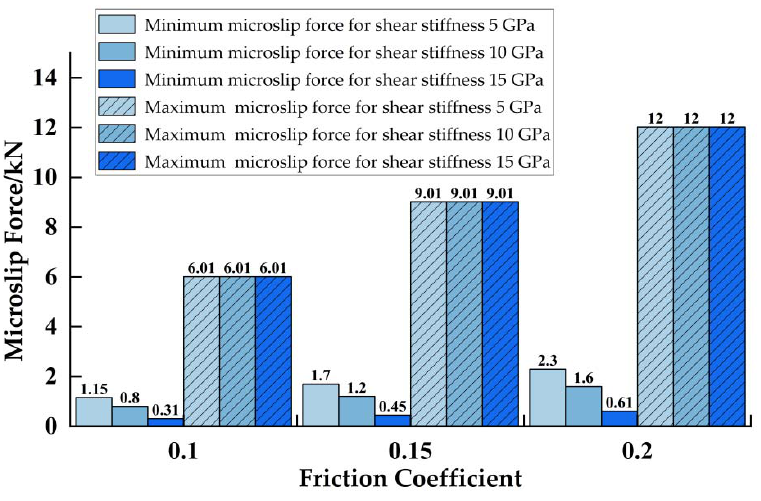
Figure 10. Critical microslip tangential force histogram.